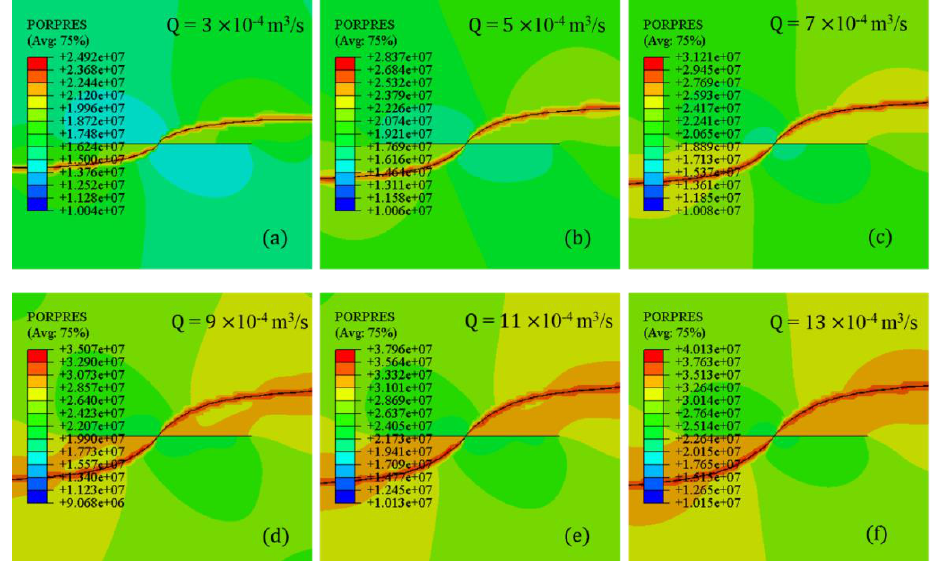
Figure 11. Reorientation behavior of refracturing fractures with different injection rate (PORPRES present the pore-pressure with enrichments: unit is Pa).